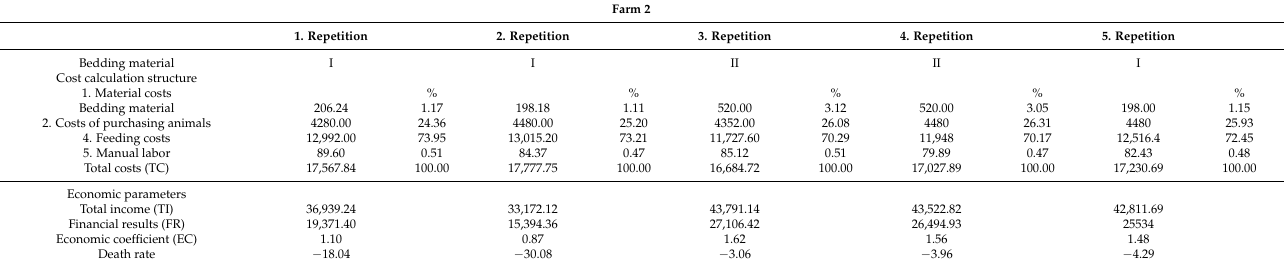
Table 7. Calculated economic results for Farm